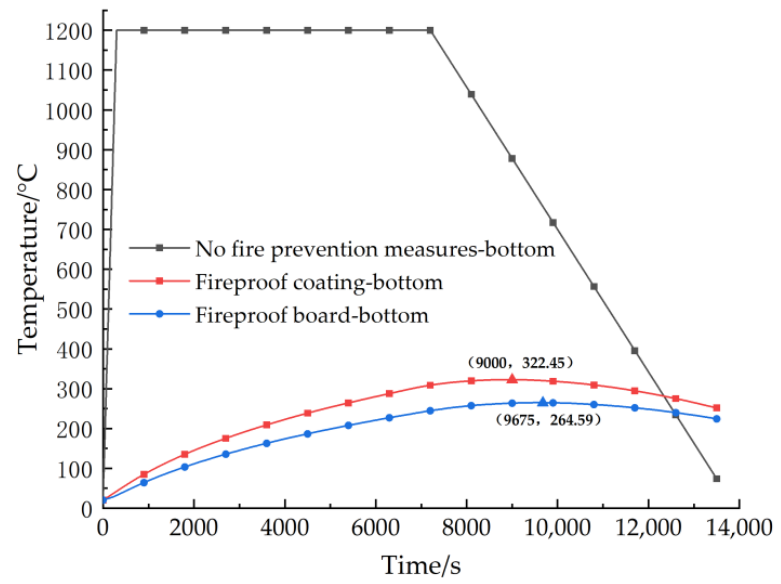
Figure 27. The temperature of measuring points on the bottom steel plate surface with and without fire protection.